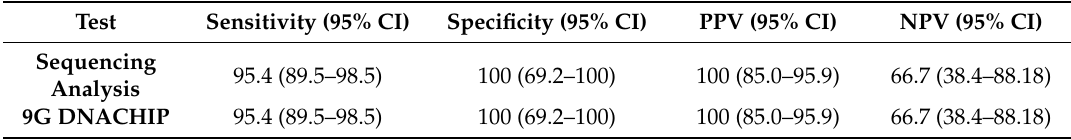
Table 4. Performance of the 9G